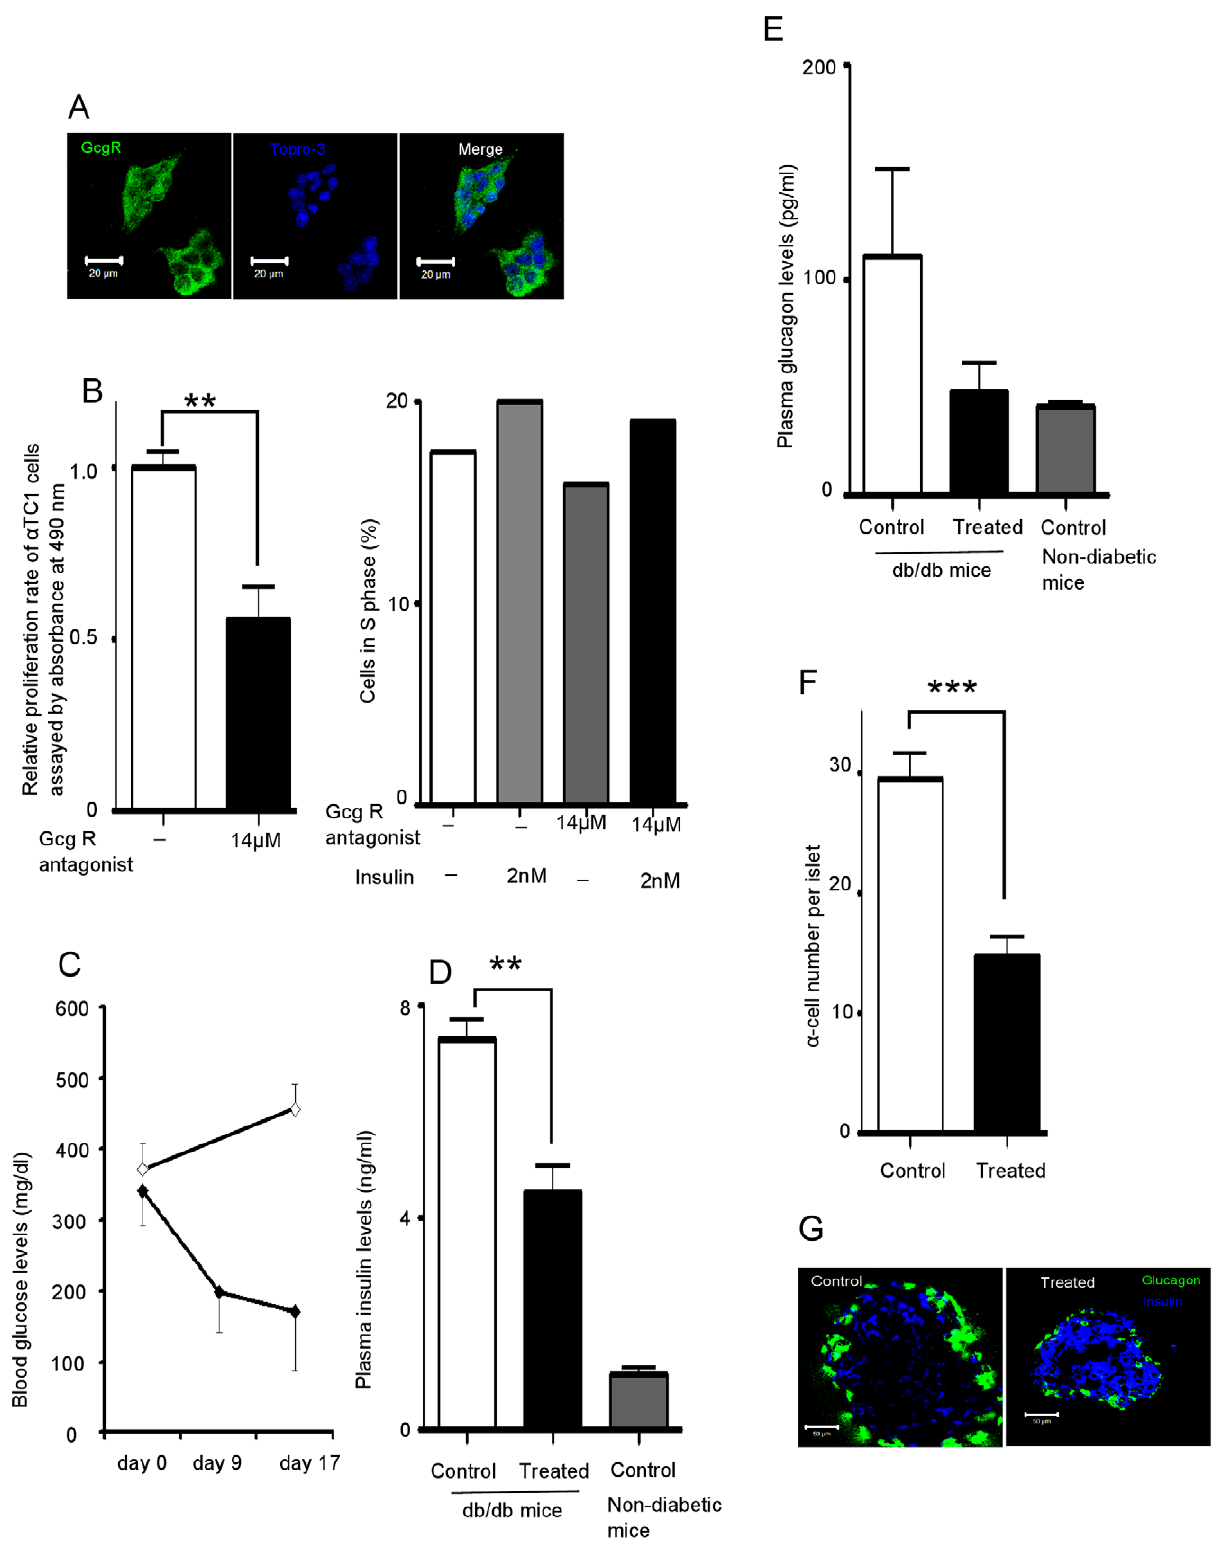
Figure 5. Glucagon receptor (GcgR) antagonism decrease a -cell proliferation. (A) Immunofluorescent staining of GcgR on a TC1 cells. (B) Proliferative response of a cells after 72 hours (left panel) or 24 hours (right panel) of GcgR antagonist II (14 m M) + / 2 insulin (2 nM) treatment. The cell proliferation was assessed by both ELISA-based relative proliferation assay (left panel) and by counting the cells in S phase (propidium iodide staining for DNA cell cycle analysis) (right panel). (C) db/db mice were treated with GcgR antagonist II for up to 17 days. Blood glucose measurements in non-treated db/db (n=4, open diamond) and treated db/db (n=5, closed diamond) mice. (D) Fasting plasma insulin levels of db/db mice